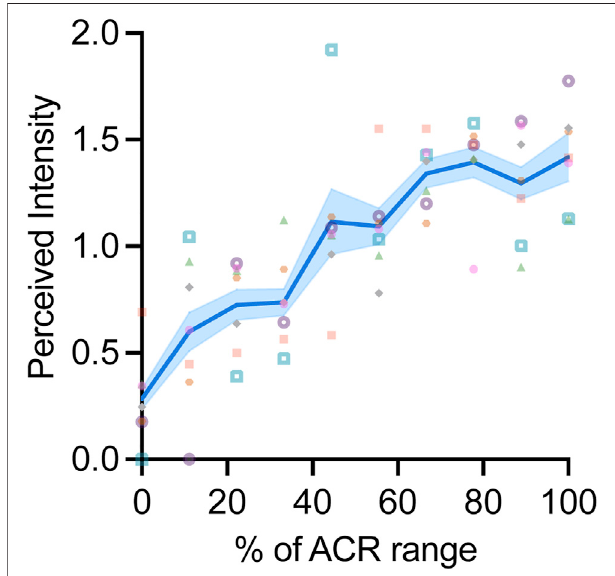
FIGURE5| Awiderangeofintensitieswereperceivedbyallparticipants. The individual markers represent the percept intensities reported by each participant across the chosen ACR range, normalized to the grand mean rating of their respective blocks. The solid blue line and blue shade represent the average of the normalized perceived intensities and SEM respectively, across all